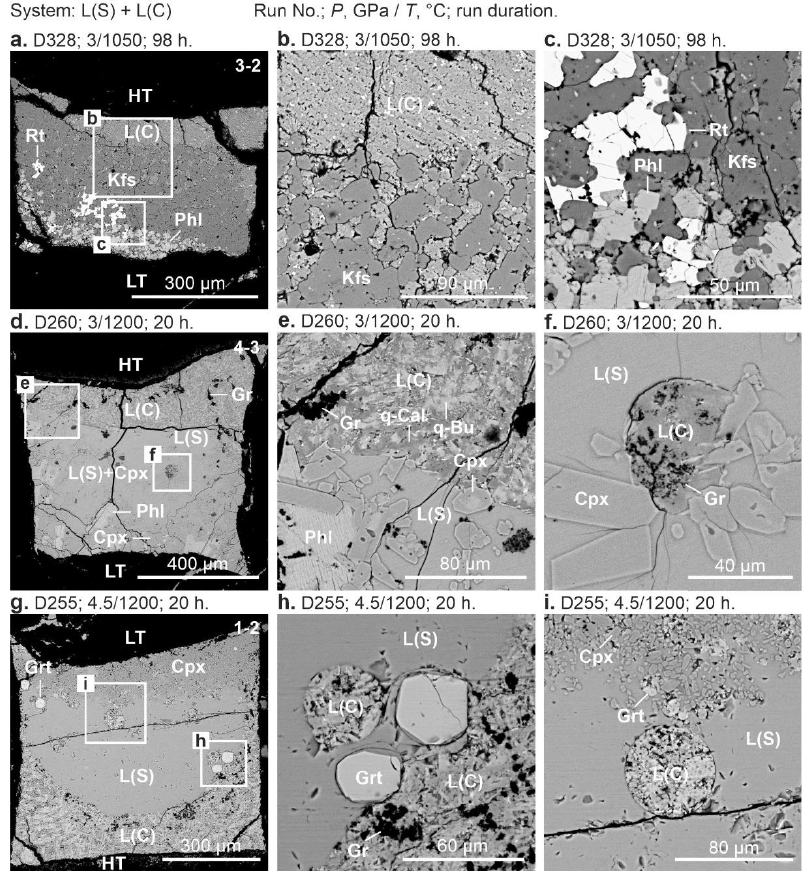
Figure 2. BSE of sample cross-sections in the system L(S)+L(C) at 3 – 4.5 GPa: ( a – c ) 3 GPa, 1050 °C (run D328, 98 h); ( d – f ) 3 GPa, 1200 °C (run D260, 20 h); ( g – i ) 4.5 GPa, 1200 °C (D255, 20 h). HT — high-temperature, and LT — low-temperature sample sides. The gravity vector is directed downward. See the Abbreviations section for mineral and phase symbols.